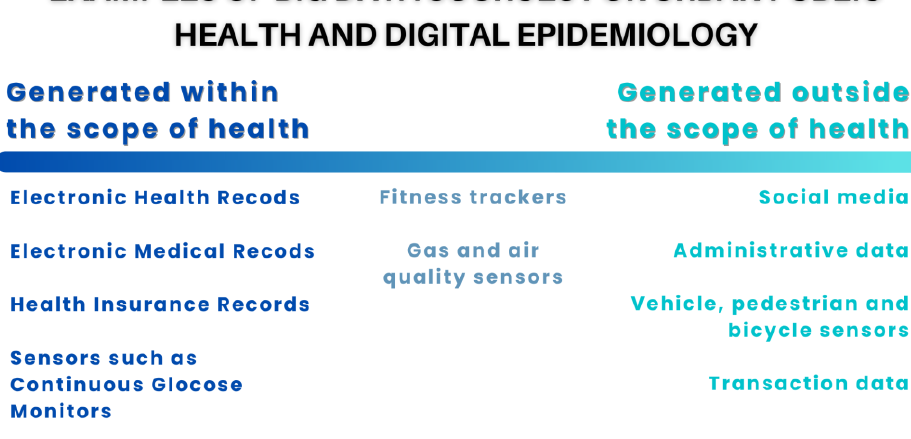
Figure 1. Data sources used in urban public health and digital epidemiology research can broadly be organized along a continuum of health orientation of the process that generated them.